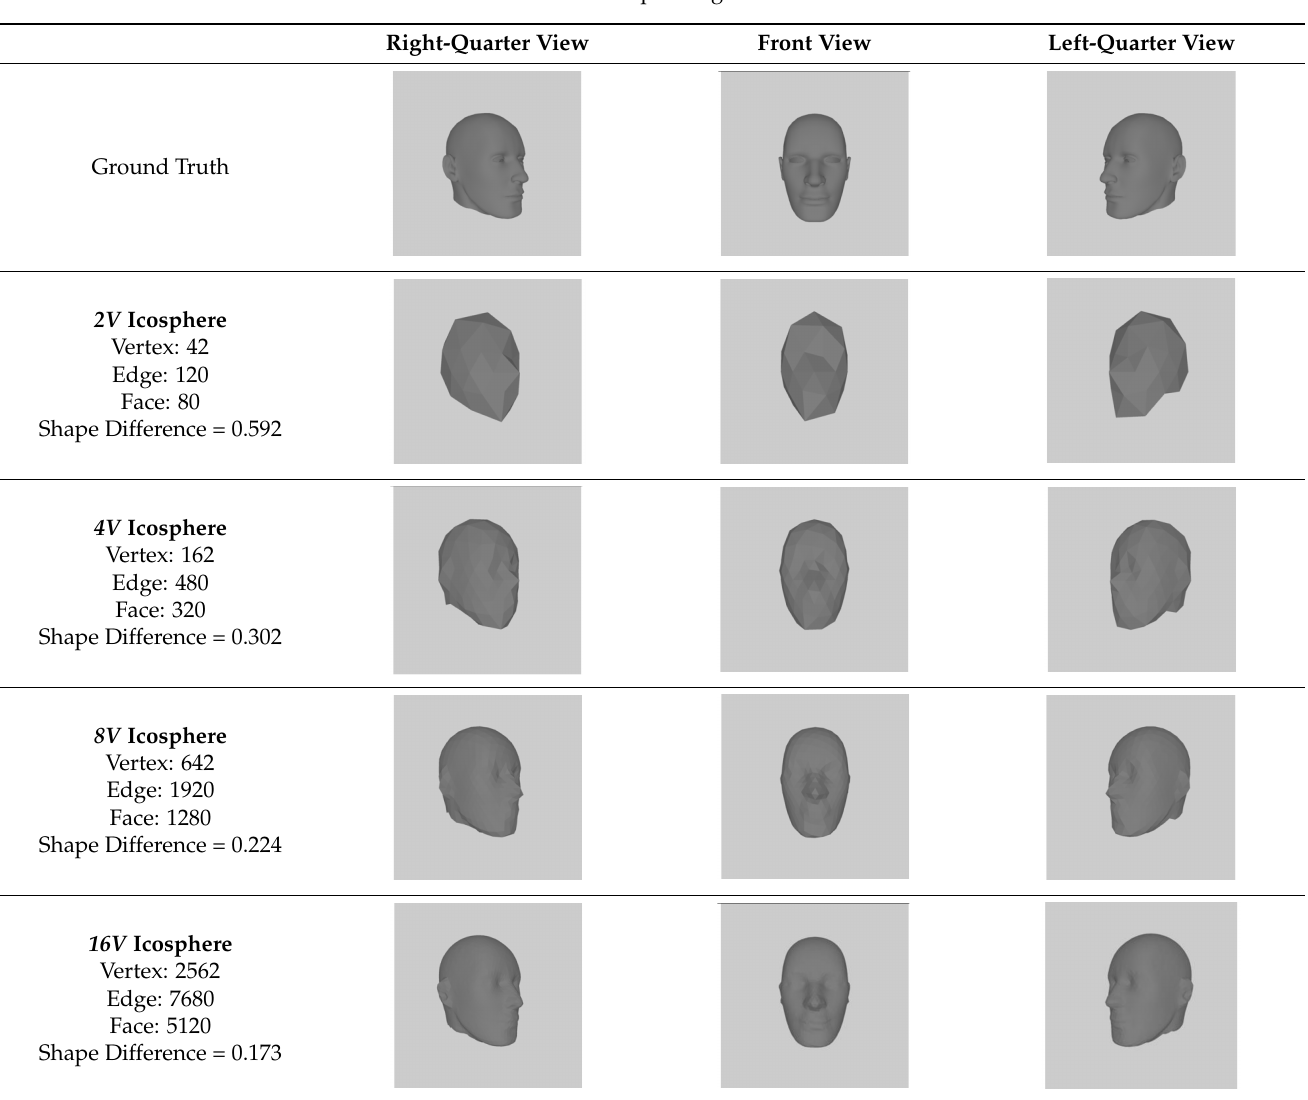
Table 2. Resolution of SCD depending on the nV